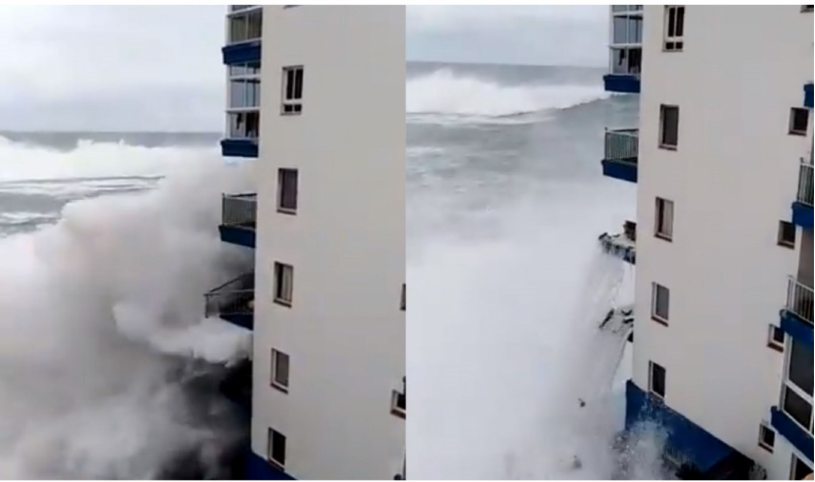
Figure 3. Action of the maritime climate on buildings right on the coast (Tacoronte, Spain, 2017). Source: own collection.